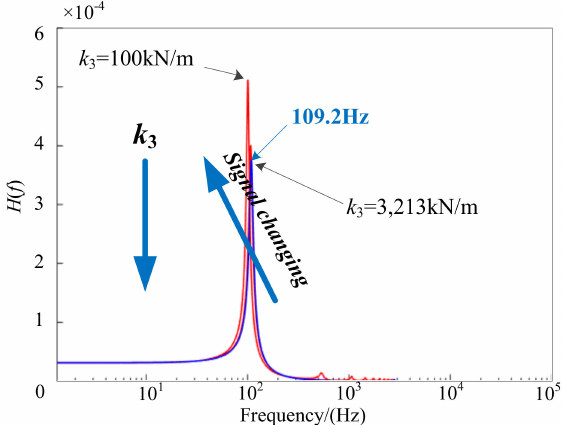
Figure 6. Effects of k 3 on the frequency response of the plastic